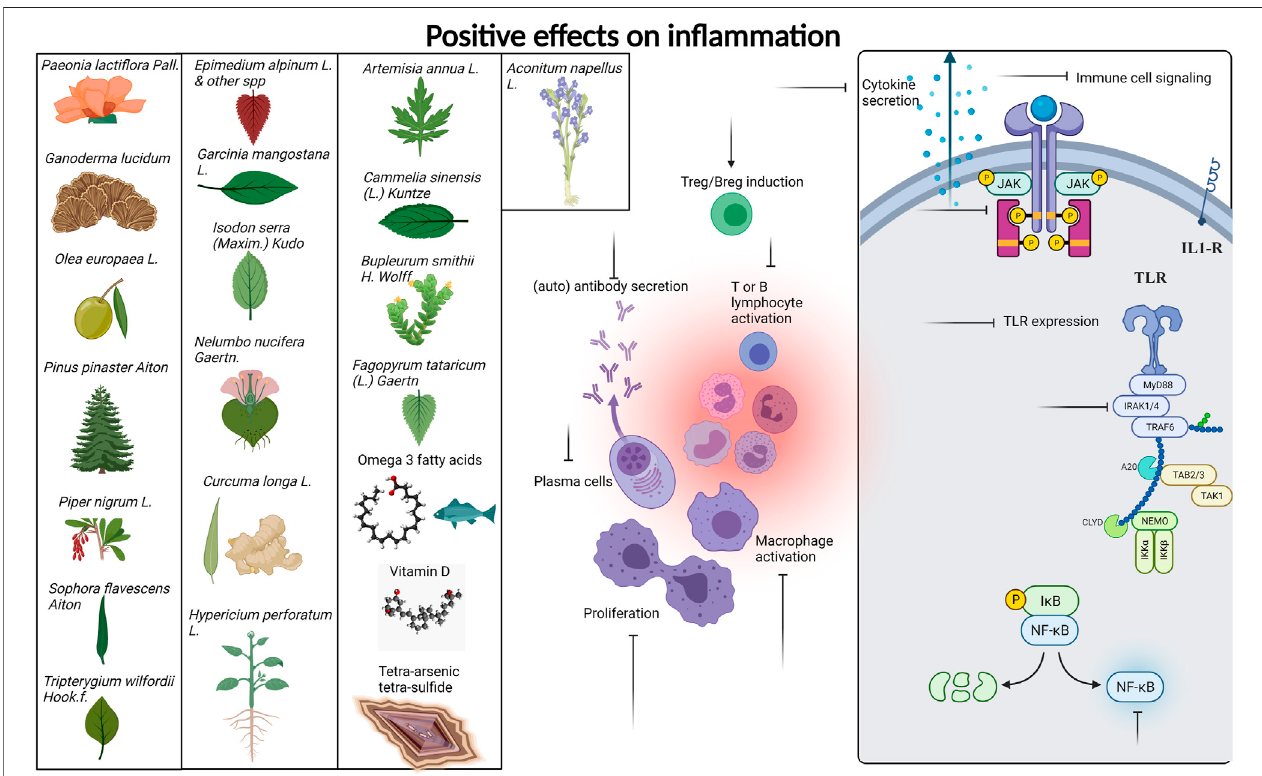
FIGURE 3 | Compounds with positive effects on in fl ammation. Plant extracts and natural compounds identi fi ed in our search that had positive effects on in fl ammation are presented at left. Speci fi c pathways of immune cells targeted by these extracts and compounds are presented at right. In fl ammatory processes targeted by natural compounds include generation of Tregs and Bregs, inhibition of lymphocyte activation, proliferation, cytokine signaling, and secretion, reduced TLR expression, and inhibition of JAK/STAT NFkB and IRAK signaling pathways. A detailed list of which compounds provided which effects are provided in Table 1 . Created with